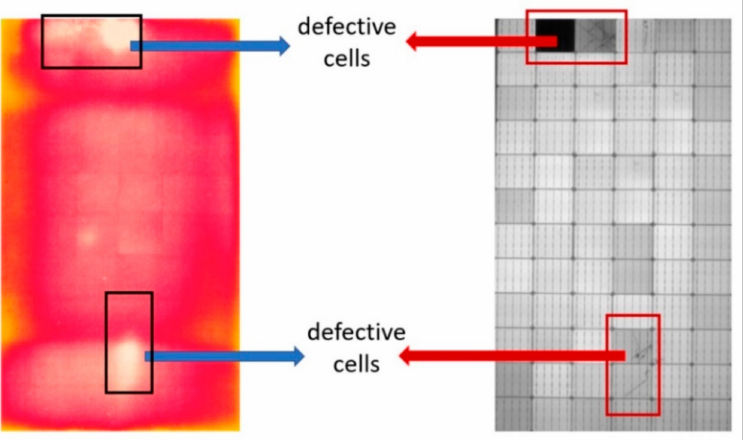
Figure 19. The equivalent location of cell defects (panel 2) both on the thermal and electrolumines- cence